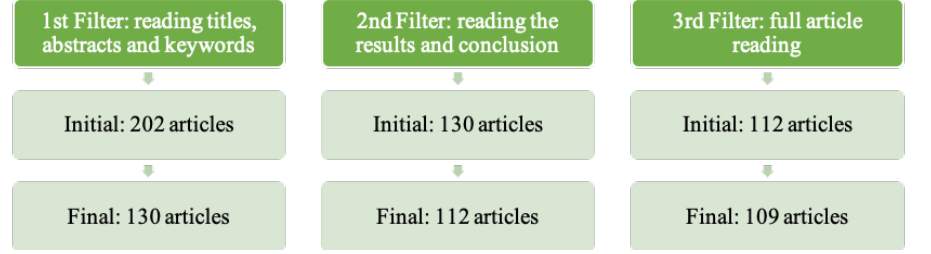
Figure 2. Summary of articles filtering after